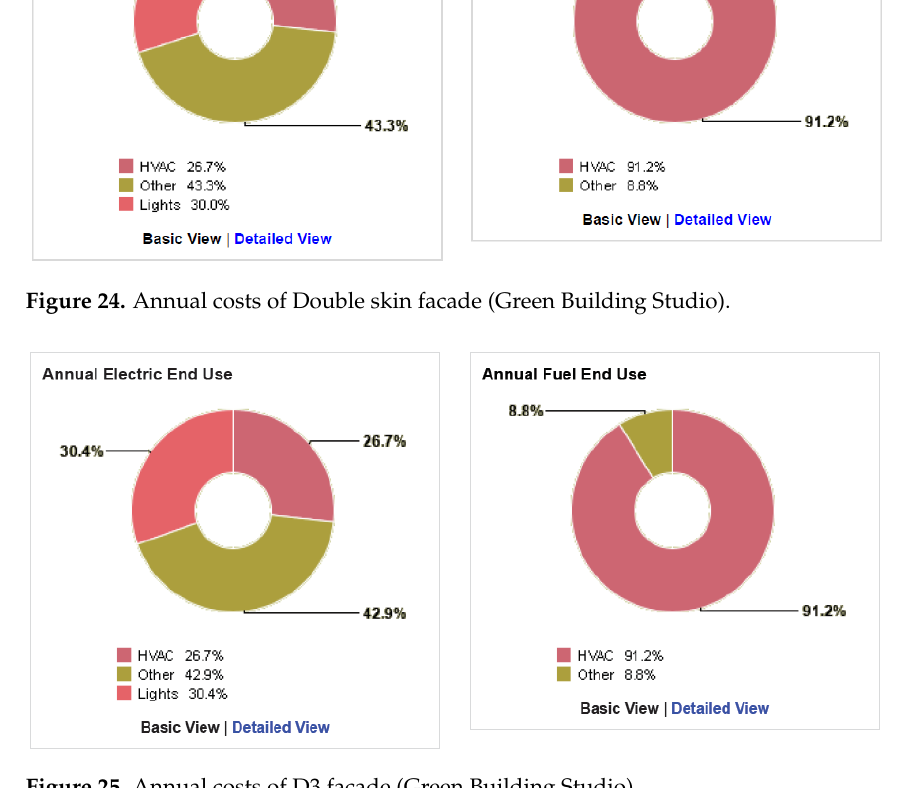
Figure 25. Annual costs of D3 facade (Green Building Studio).